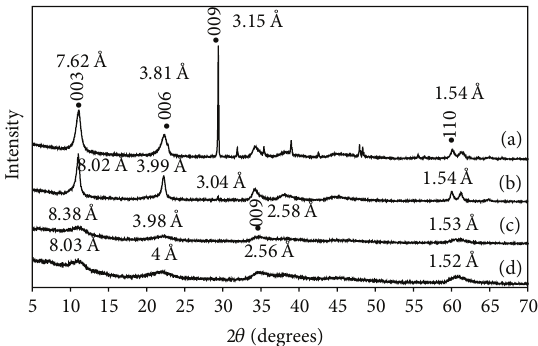
Figure1:XRDpatternsof(a)originalMg-Al-NO 3 ,(b)Mg-Al-NO 3 - Pb, (c) tartrate Mg-Al and (d)